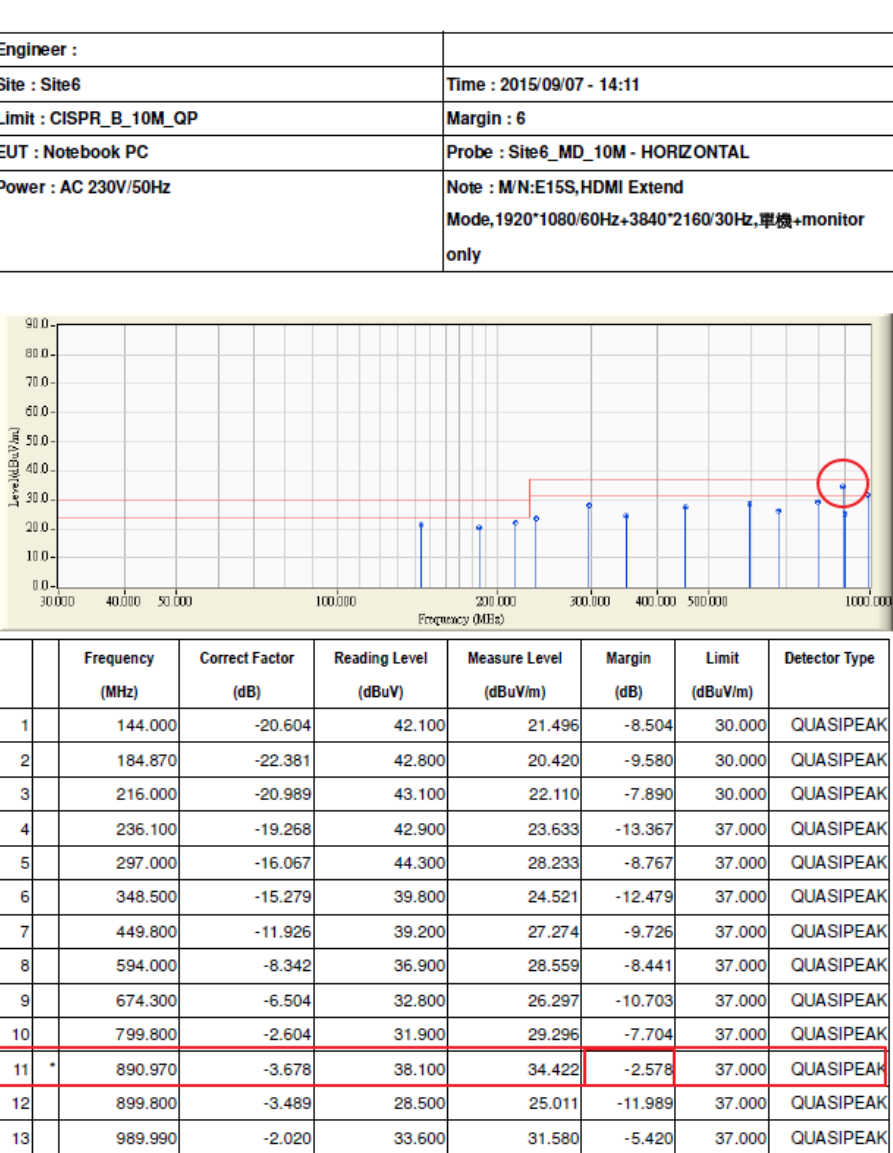
Figure 2. Radiation 30 MHz to 1GHz measurement result data.